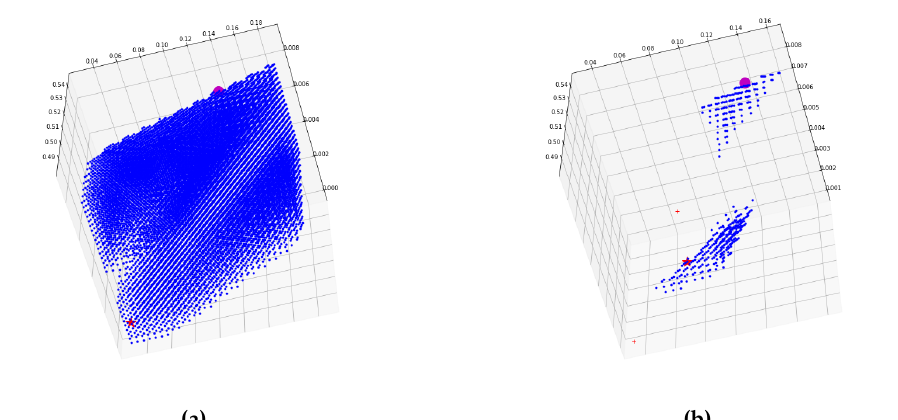
Figure 10. The intersection region I zr ⊂ R 3 at different number of tests involved. On the left a few tests have created a single connected region while, on the right, adding more tests have splitted it into two subregions. For graphical reasons the region has been discretized and the dots are the grid nodes; the bigger ball is the true solution and the star is the current estimate in the experiment. ( a ) A (portion of a) connected region I zr ; ( b ) A region I zr split into two not connected sub